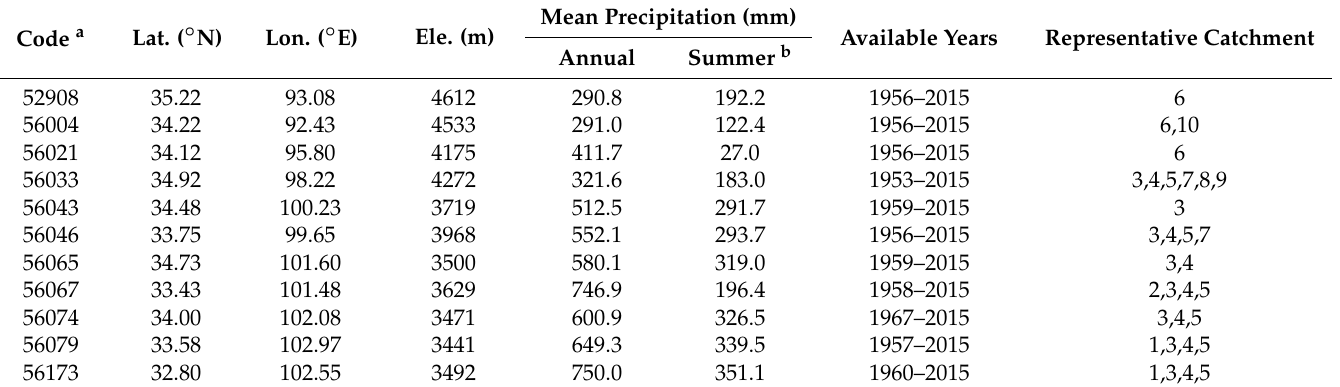
Table 2. General information about the meteorological